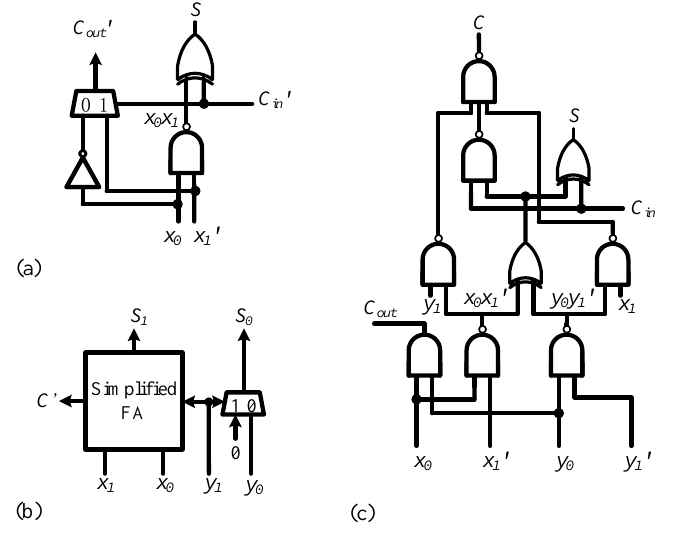
Figure 5. ( a ) Proposed full adder (FA). ( b ) 4-bit full adder. ( c ) Simplified 4-2